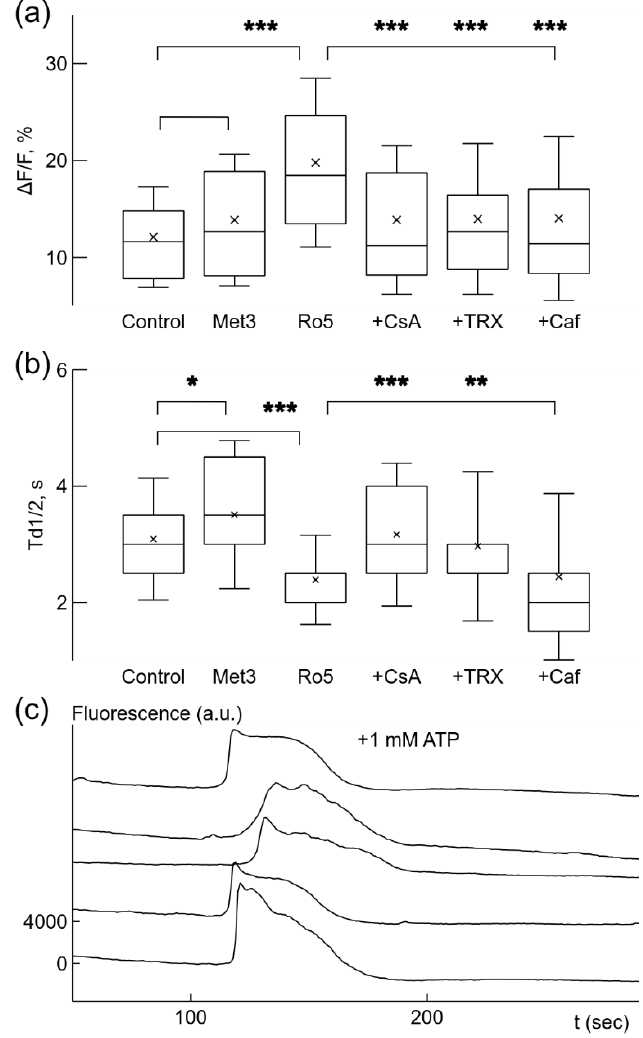
Figure 3. Ca 2+ signal parameters were changed by drugs under normoxic conditions. Box-and- whisker plots illustrate changes in relative signal amplitude, ∆ F/F, ( a ) and the time of decay to half-amplitude, Td1/2, s, ( b ) of spontaneous Ca 2+ sensitive fluorescence signals in microglial cells. Application of 3 mM metformin (Met3) did not significantly change the relative amplitude ( a ) but increased the time of decay ( b ). Addition of 5 nM rotenone (Ro5) significantly increased the signal strength ( b ) and reduced the time of decay ( b ). Other drugs were added separately when 5 nM rotenone was already present. 10 µ M CsA (+CsA) and 100 µ M trolox, TRX (+TRX) reduced signal strength ( a ) but increased the time of decay ( b ) comparing to values after rotenone only, while 5 mM caffeine (+Caf) reduced the signal amplitude only ( a ). ( c ) Application of 10 µ M CsA together with 5 mM caffeine blocked generation of spontaneous Ca 2+ signals facilitated by 5 nM rotenone, but addition of 1 mM ATP evoked Ca 2+ -dependent fluorescence changes in simultaneously recorded traces. Note the absence of fast Ca 2+ signals in the traces. The traces were shifted by 4000 a.u. in relation to each other in ( c ). * p < 0.05, ** p < 0.01, *** p < 0.001 (Welch’s t